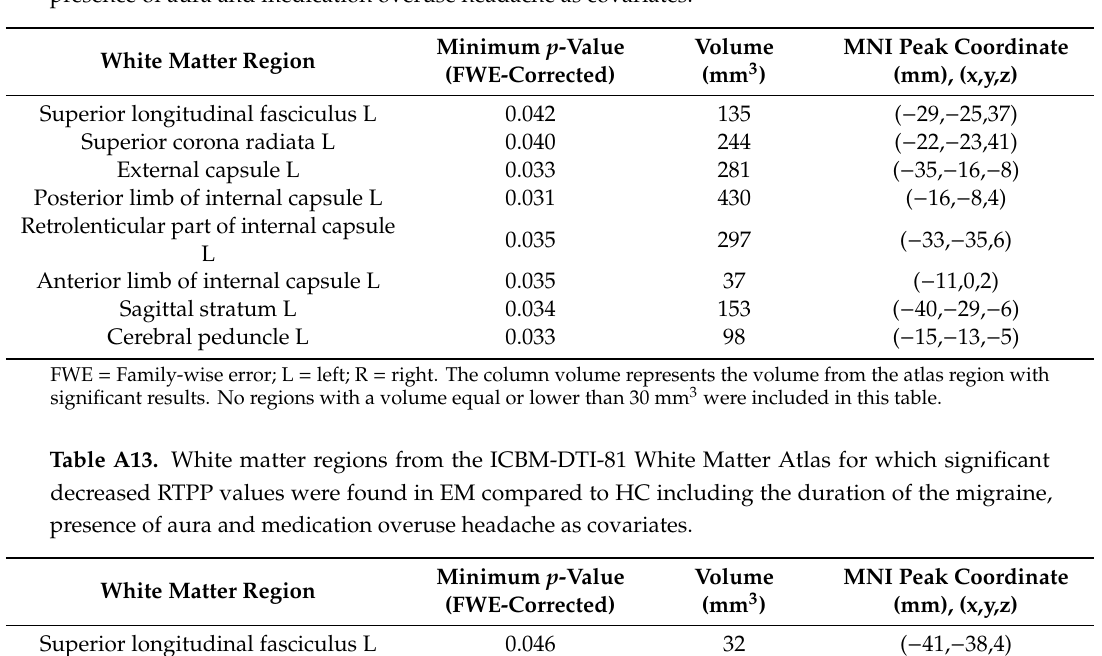
Table A12. White matter regions from the ICBM-DTI-81 White Matter Atlas for which significant increased AD values were found in EM compared to HC including the duration of the migraine, presence of aura and medication overuse headache as covariates.